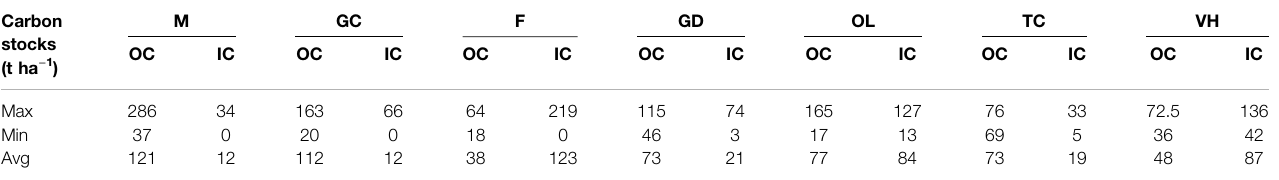
TABLE 1 | Variation of SOC and SIC stocks under the selected vegetation covers. Carbon stocks